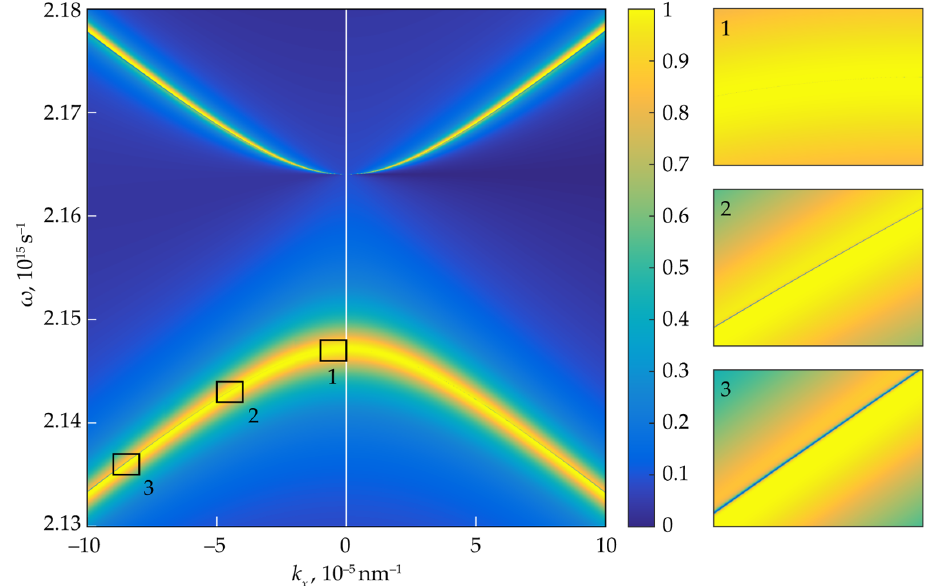
, r k  of the stacked structure calculated using Figure 4. Magnitude of the reflection coefficient   Figure 4. Magnitude of the reflection coefficient | r 2 ( k x , ω ) | of the stacked structure calculated 2 x using RCWA (left half, k x < 0) and using the resonant approximation (14) (right half, k x > 0) (TE RCWA (left half, 0 k  ) and using the resonant approximation (14) (right half, 0 k  ) (TE polari ‐ x x polarization) with the intermediate layer thickness l = 6.522 µ m The insets show the magnified zation) with the intermediate layer thickness 6.522 μ m l  The insets show the magnified fragments fragments of the left part of the of the left part of the figure.